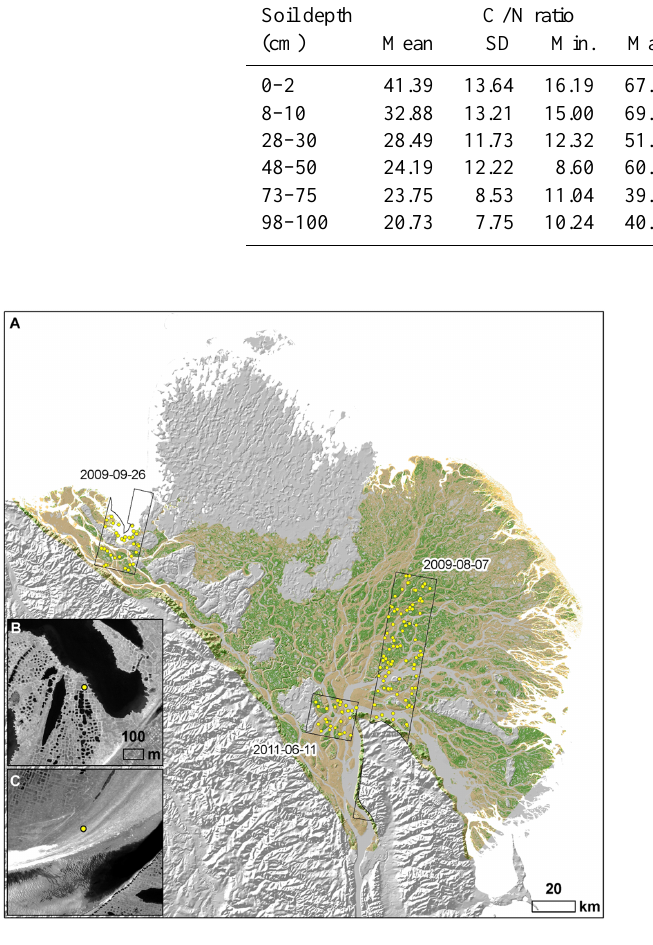
Fig. 3. (A) Delta classification overview showing areas covered with very high resolution WorldView-1 data (© DigitalGlobe) (black frames, including acquisition date) used for ground truth of the classification (150 yellow dots). (B) Example of ground truth point on Holocene terrace. (C) Example of ground truth point on active floodplain.